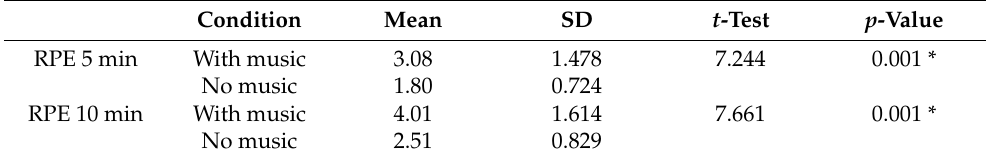
Table 4. Table with and without music for RPE differences (Unit: